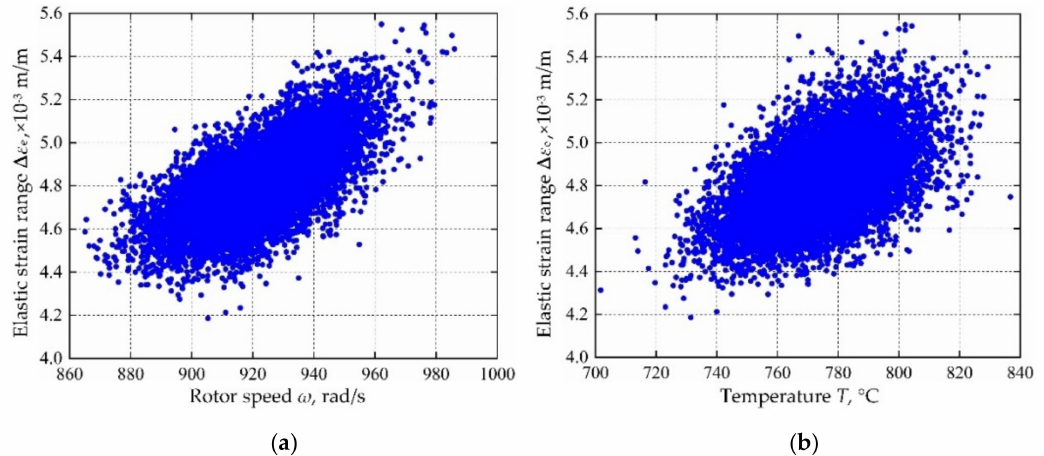
Figure 15. Scatter sketches of elastic strain range: ( a ) rotor speed, ( b ) temperature.